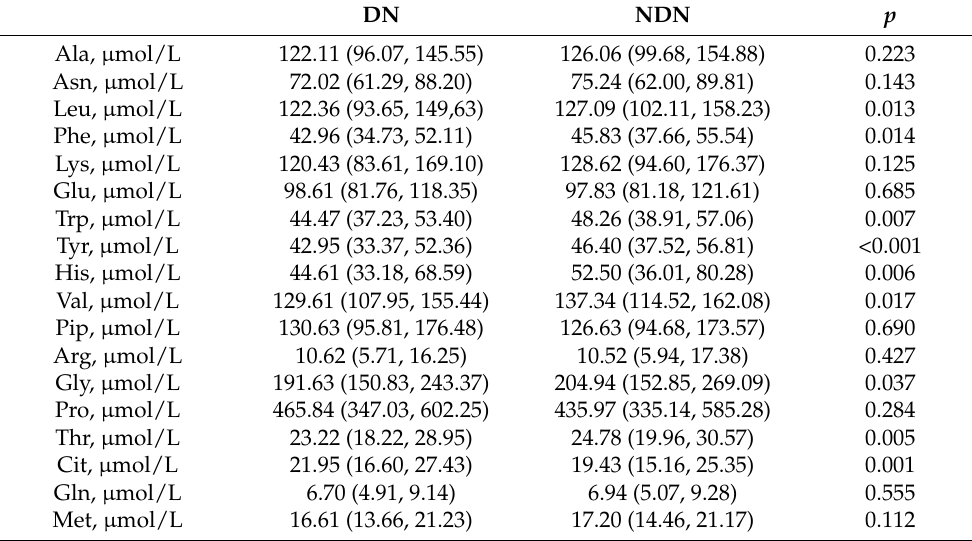
Figure 3.: Spearman correlation coefficients between selected plasma amino acids and DR (n = 1031). The number and the color of grid represent the magnitude of the correlation coefficient and the correlation, respectively. Darker blue means more positive correlation, and darker red means more negative correlation. DR was divided into binary variables according to whether or not. Leu, leucine; Phe, phenylalanine; Trp, tryptophan; Tyr, tyrosine; Val, valine; Gly, glycine; Thr, threonine; Cit, citrulline; His, histidine; Ser, serine, DR, diabetic retinopathy. * p -value < 0.05, ** p -value < 0.01, *** p -value < 0.001. Table 3. Odds ratio of significant amino acid for the risk of diabetic nephropathy stratified by diabetic retinopathy. Table 2. Plasma amino acids levels according to DN